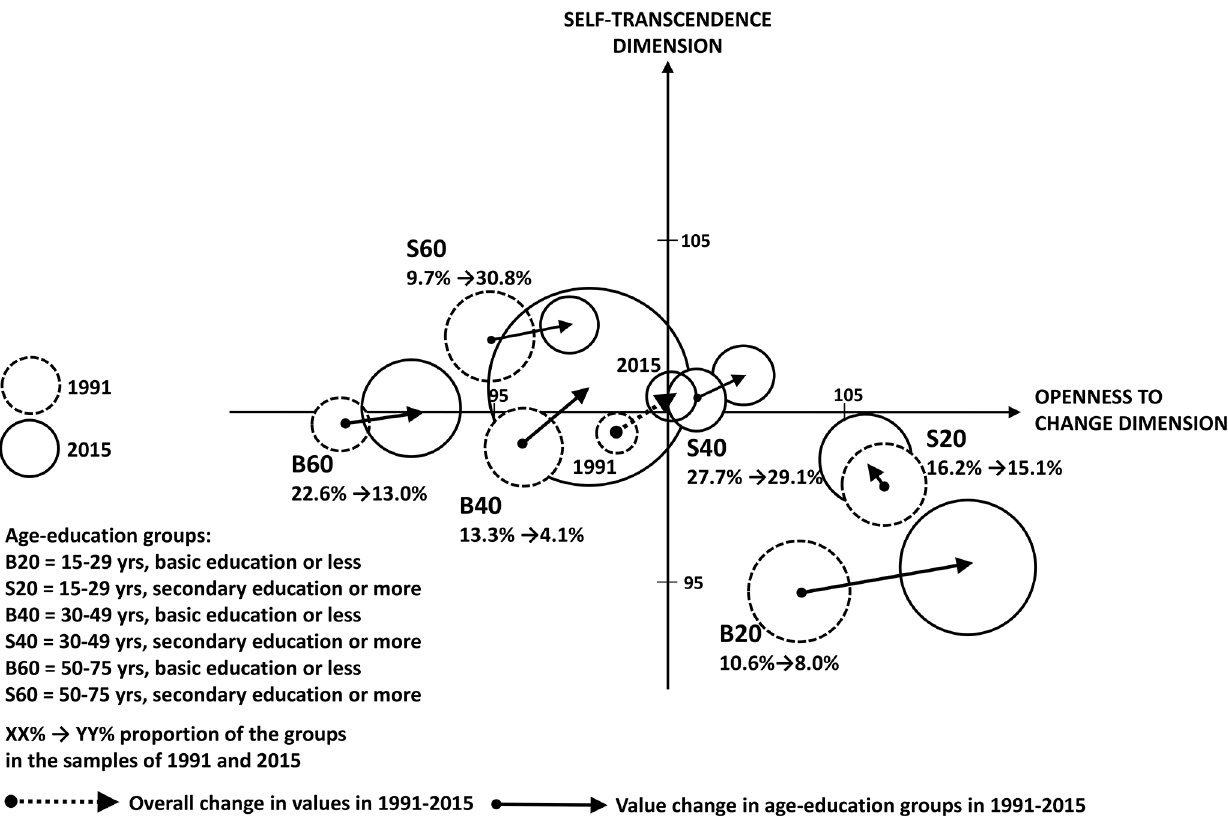
Figure 3. Age-education groups on the value map in 1991 and 2015. The diameter of the circles indicates the bivariate 95% confidence interval (for interpretation, see